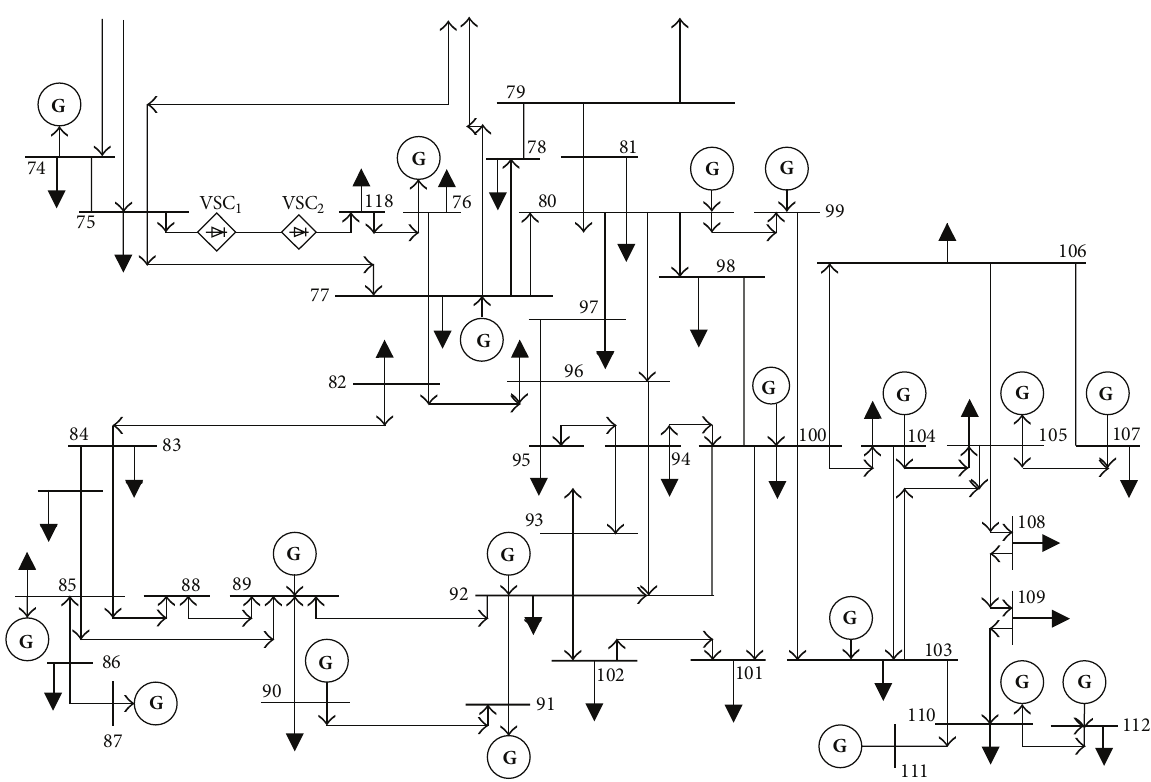
Figure 8: Relevant part of the modified IEEE 118-bus system